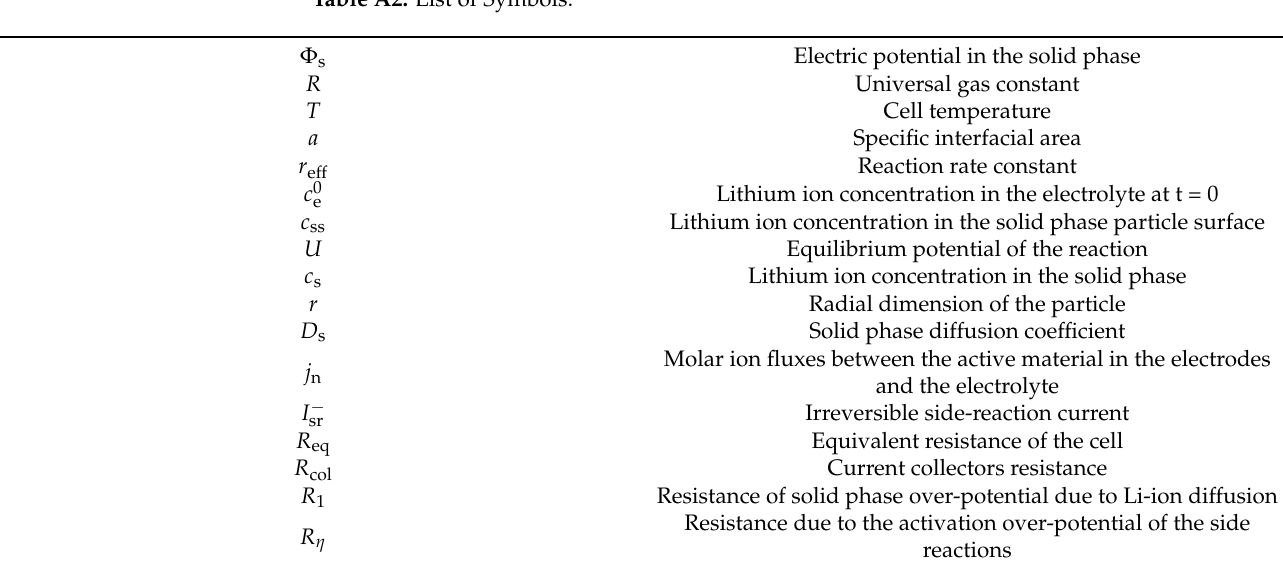
Table A2. List of